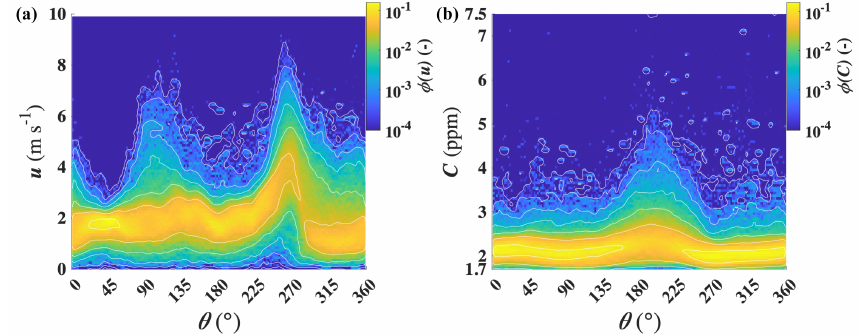
Figure 5. (a) Wind direction, θ , and wind speed, u , resolved probability distribution, ϕ(θ,u) , and (b) concentration probability distribution, ϕ(θ,C) , for 1990–2016. The white dashed line shows the edges of the seep field. Data key is shown in the